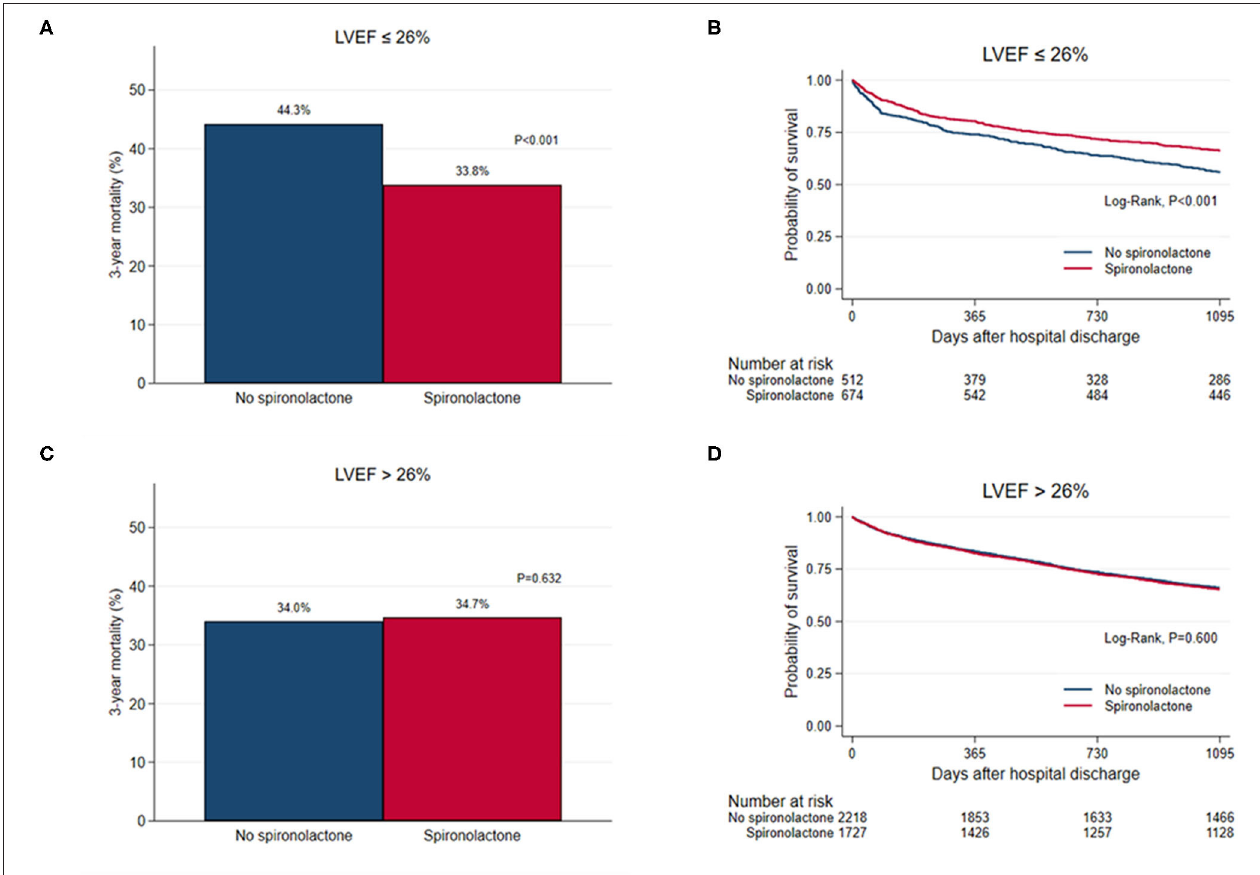
FIGURE 3 | (A,C) Bar graph and (B,D) Kaplan–Meier curves of the 3-year all-cause mortality after hospital discharge according to spironolactone treatment in patients with left ventricular ejection fraction (LVEF) ≤ 26% and in patients with LVEF >